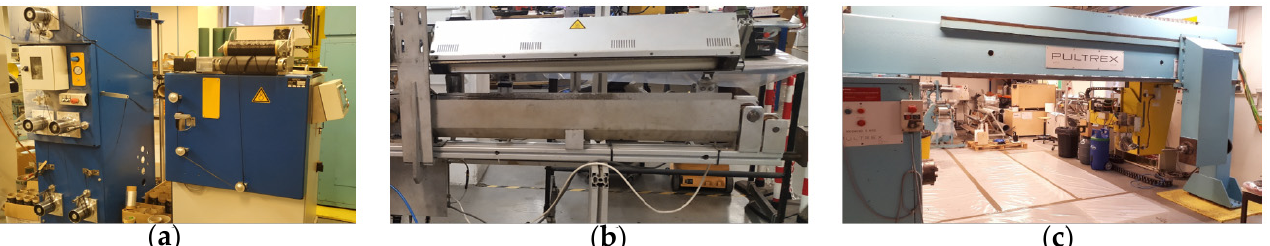
Figure 4. Equipment used in this experiment: ( a ) Commingling machine; ( b ) Pre-heater; ( c ) Winding